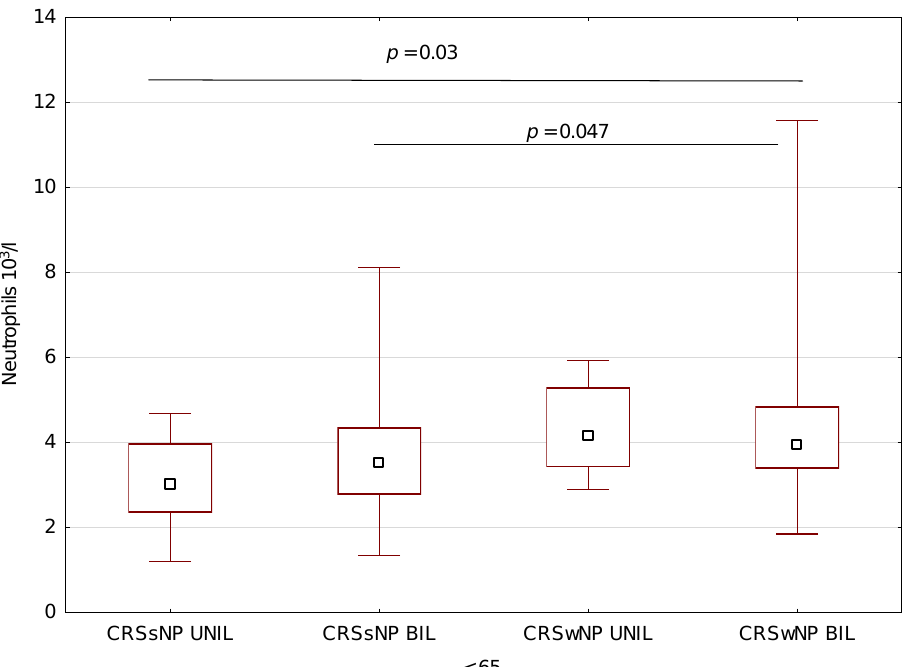
Figure 3. Lymphocytes in the peripheral blood in the two groups of patients (≥65 and <65 years of age).